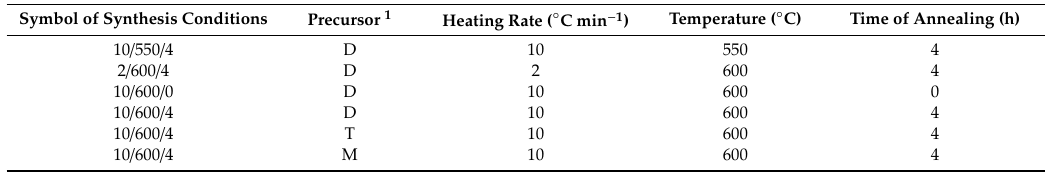
Table 2. Synthesis conditions of g-C 3 N